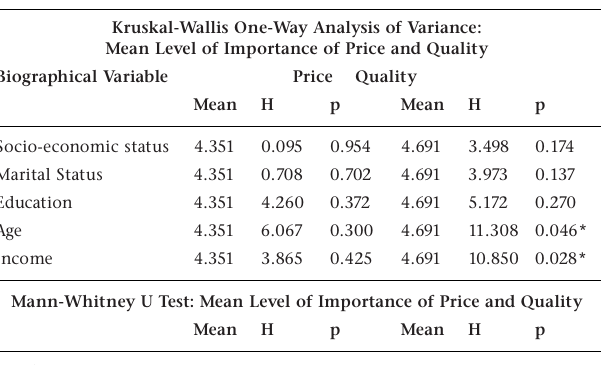
Figure 1: Mean level of importance of evaluative criteria T ABLE 3 M EAN LEVEL OF IMPORTANCE OF PRICE AND